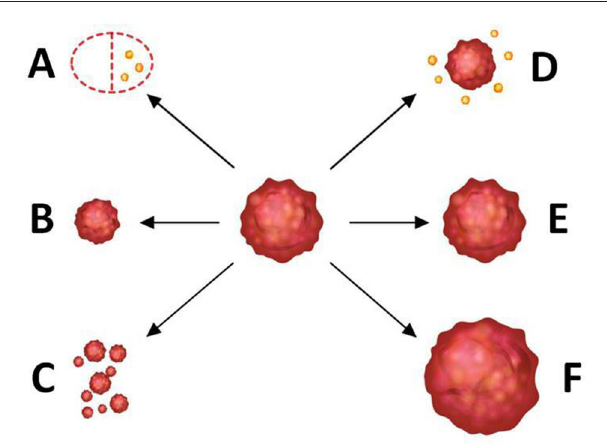
FIGURE 1 | Tumor shrinkage patterns after neoadjuvant chemotherapy. (A) Pathological complete response [i.e., no residual tumor or only residual ductal carcinoma in situ (DCIS), defined as ypT 0 / is ], (B) concentric shrinkage (i.e., only one residual invasive tumor focus, without DCIS), (C) multifocal shrinkage (i.e., more than 2 invasive tumor foci, with/without DCIS), (D) diffuse shrinkage (i.e., a main residual invasive focus with surrounding satellite DCIS), (E)